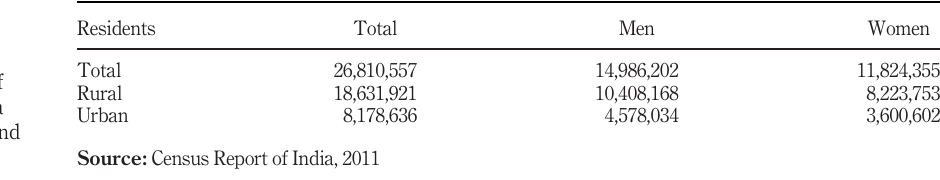
PWDs in India among rural and urban